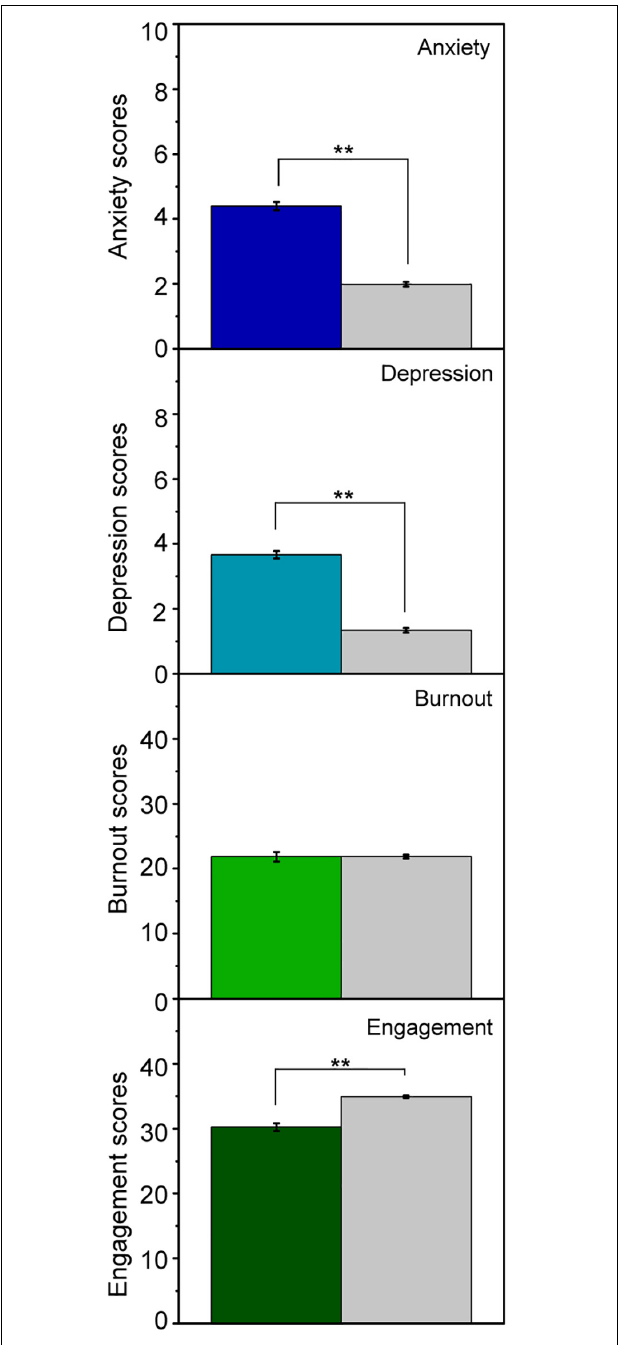
FIGURE 2 | Graduate student vs. general worker population. Comparison of the work-related mental health issues scores between the graduate student population (color bars) and the general working population (gray bars). The graphs show mean values, with error bars representing the standard error of the mean. Statistical significance: ** p <